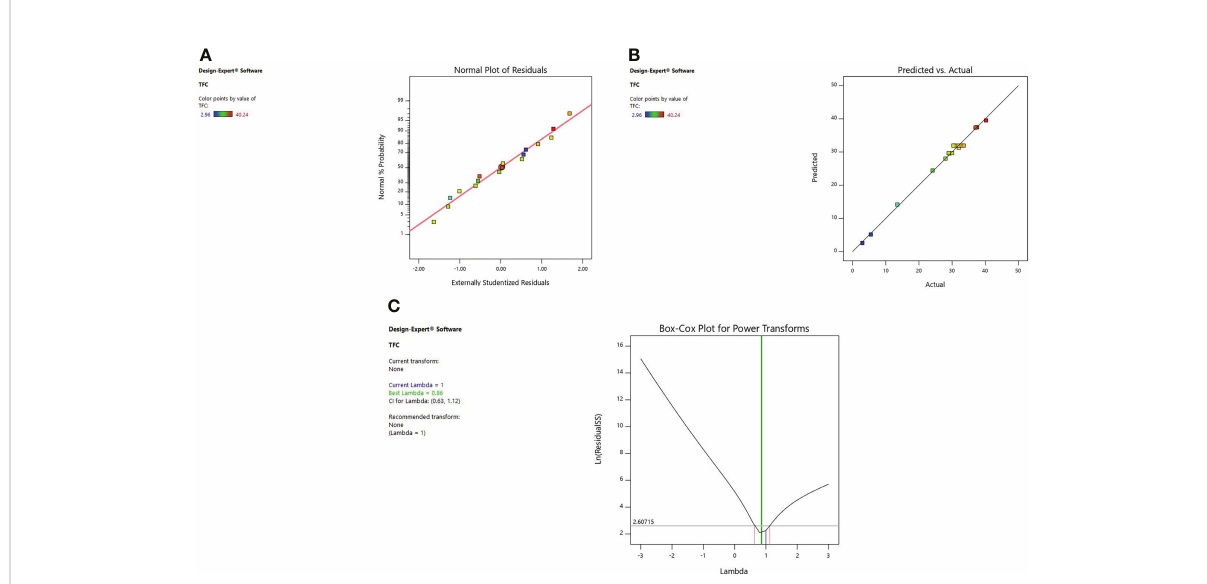
FIGURE 3 Diagnostic plot of TFC; (A) Normal % probability versus internal residual, (B) Actual versus predicted values, (C) Box-cox